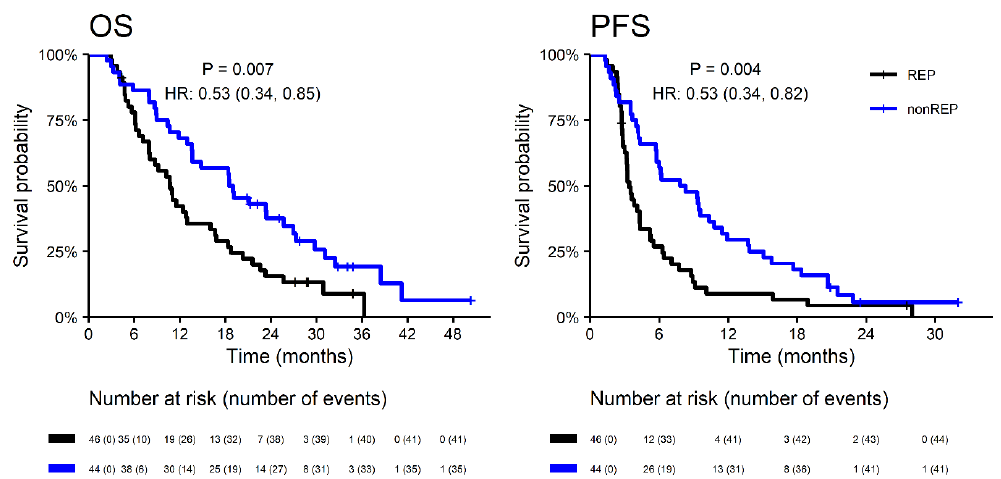
Figure 2. Overall survival and progression-free survival in patients with REP vs. non-REP. OS—overall survival; PFS—progression free survival; HR—hazard ration; REP—rapid early progression.